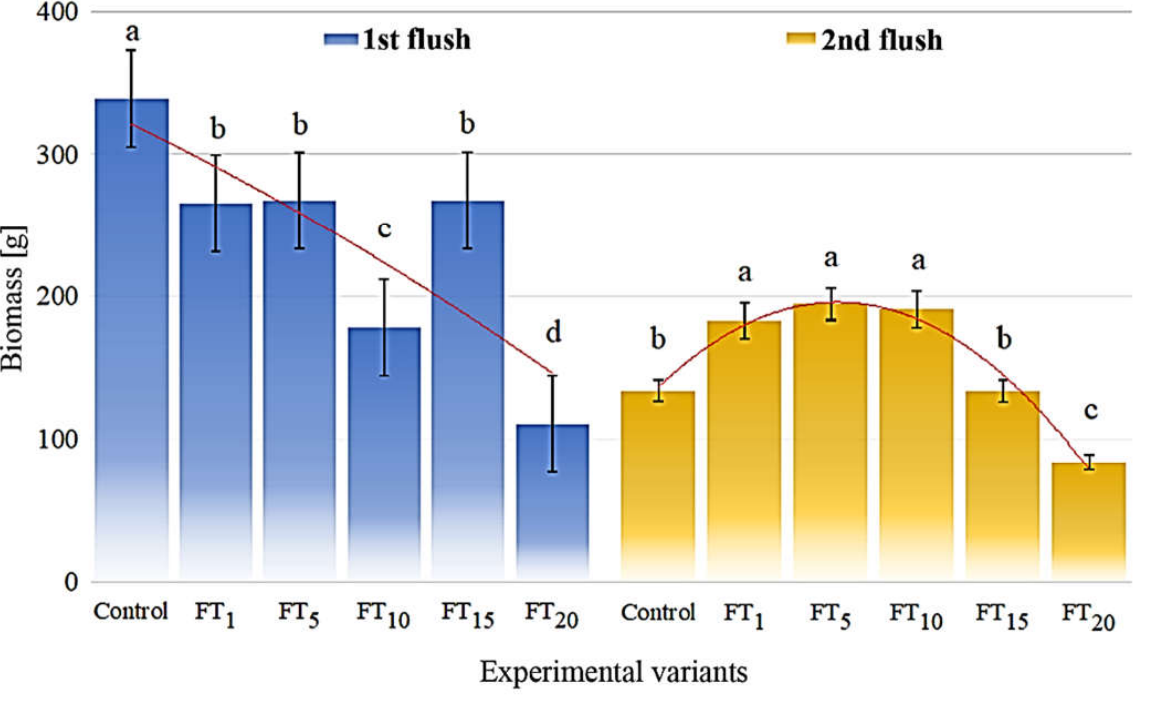
Figure 3. Biomass of Agaricus bisporus treated with particular flotation tailing addition; identical superscripts (a, b, c…) denote non-significant differences between means in columns determined in compost with flotation tailings and fruit bodies separately according to the post hoc Tukey’s HSD test.